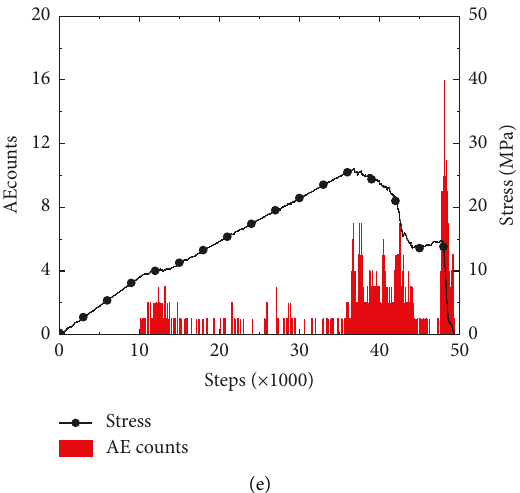
Figure 8: AE counts of rocks with different joint cross-angles. (a) β � 30 ° . (b) β � 60 ° . (c) β � 90 ° . (d) β � 120 ° . (e) β � 150 °